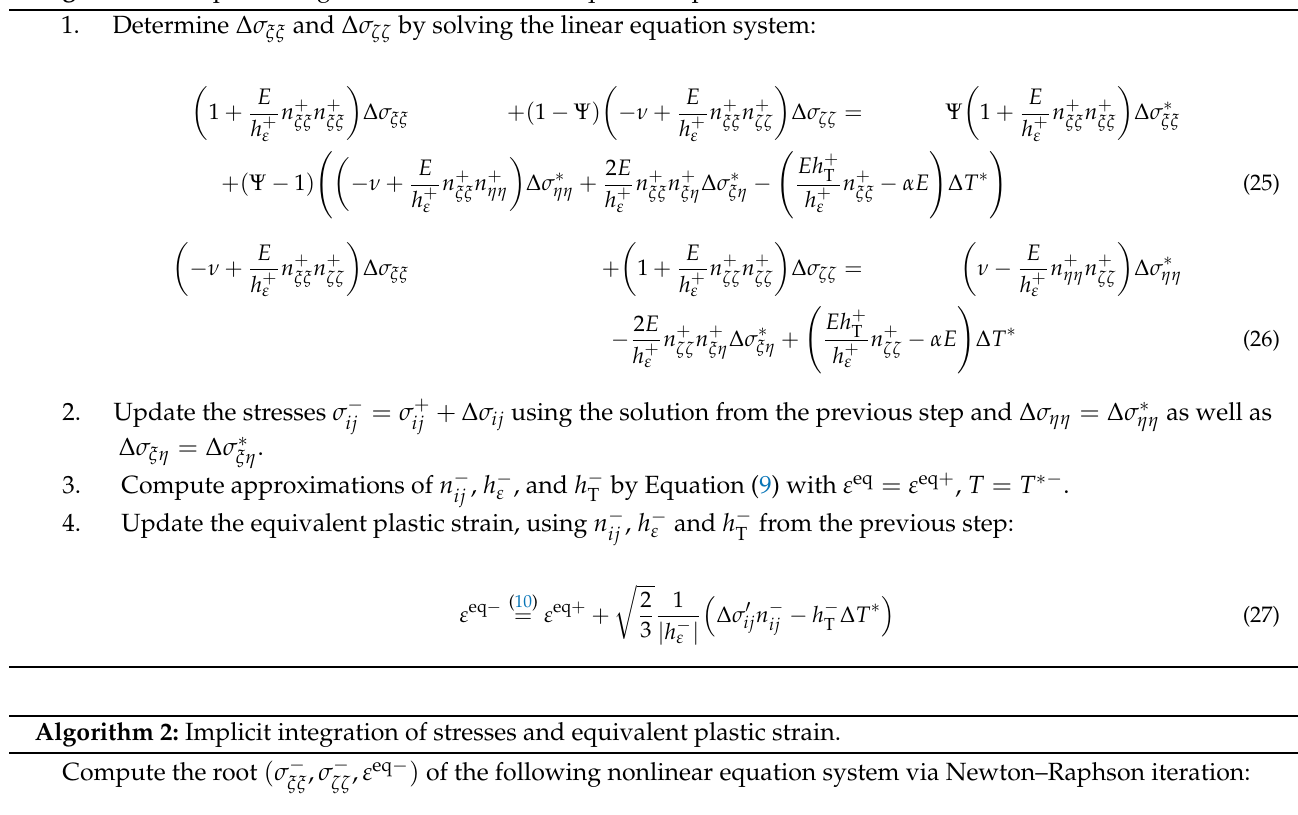
Algorithm 1: Explicit integration of stresses and equivalent plastic strain.